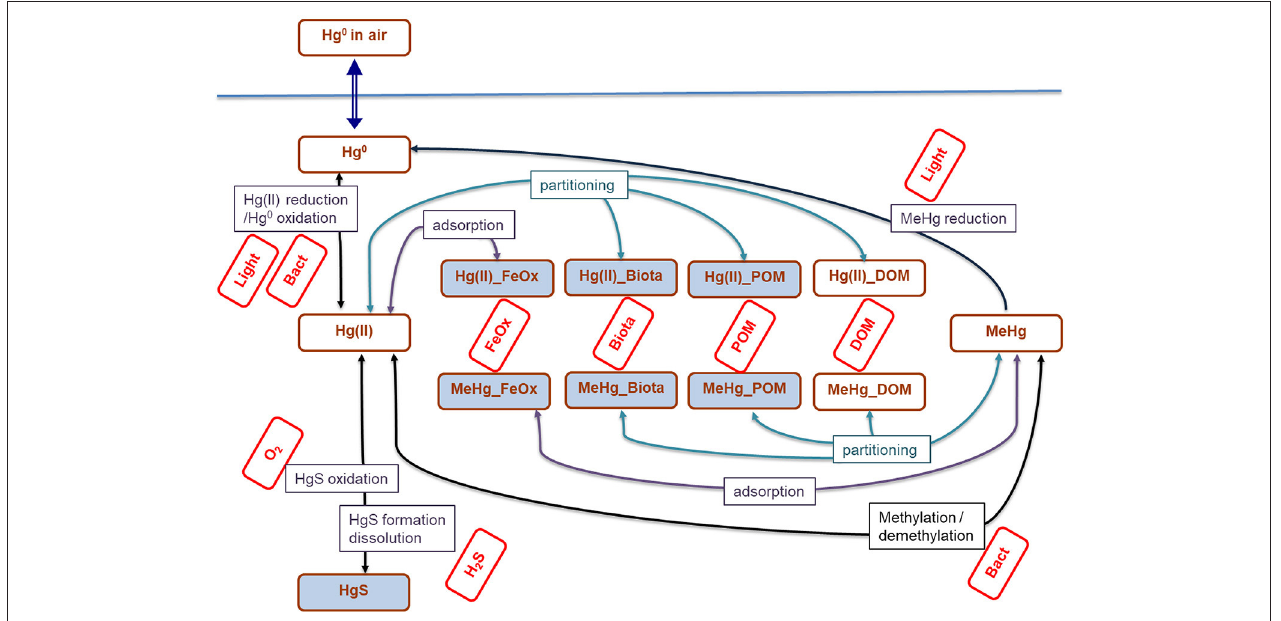
FIGURE 1 | Mercury transformations in aquatic ecosystems parametrized in the brom_hg module. Brown rectangles correspond to the state variables in the brom_hg module, red rectangles correspond to the state variables of BROM ( Yakushev et al., 2017), whose concentrations are used in calculations of Hg transformations. Uni-directional arrows reflect the processes considered in the model and the bi-directional arrow represent air-water fluxes. Open brom_hg rectangles represent dissolved species and shaded ones represent particulate species. Hg enters the system via exchange with the atmosphere; all other processes occur both in the pelagic and benthic parts of the model.